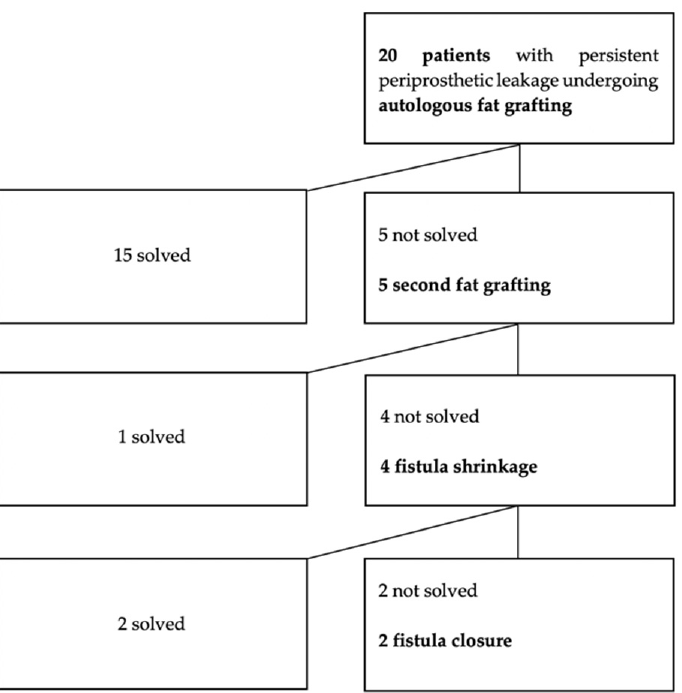
Figure 2. Flow chart of the 20 patients with persistent periprosthetic leakage treated with fat grafting.